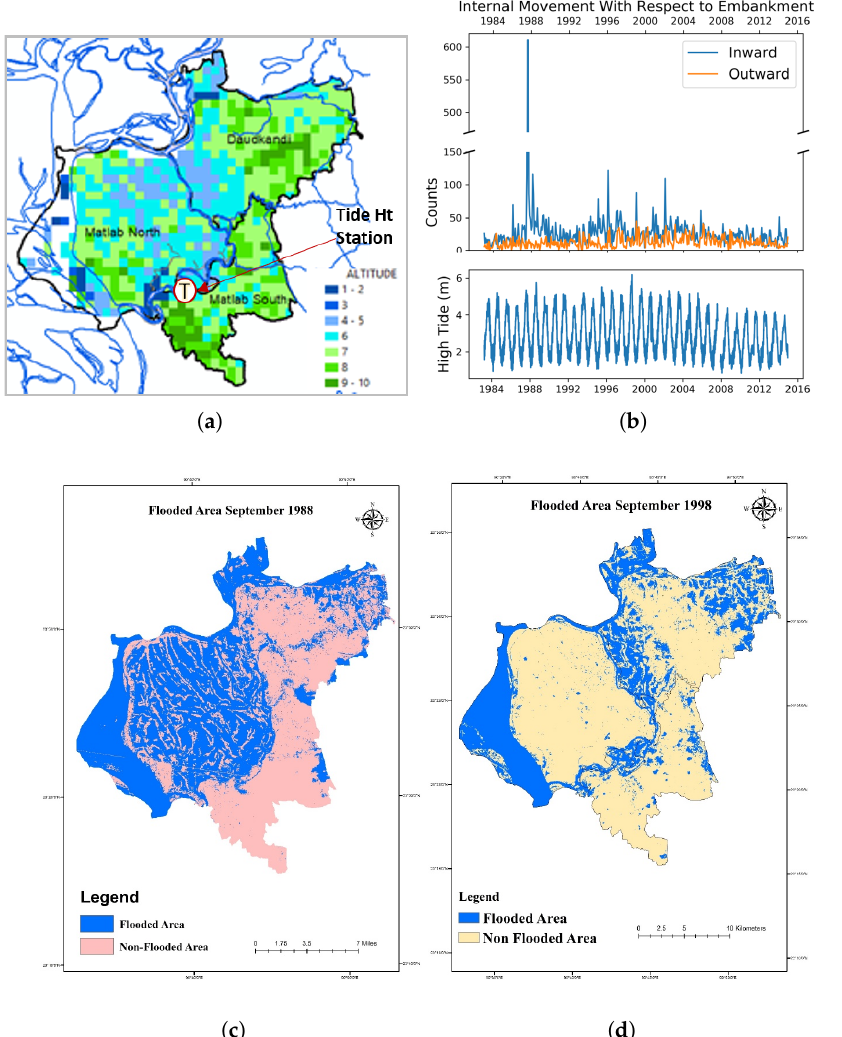
Figure 5. ( a ) Land elevation map of Matlab North, Matlab South and Daudkandi Upazilas based on 20 m × 200 m National DEM data (Source of data: WARPO), ( b,c ) inundated area in Matlab North, Matlab South and Daudkandi Upazilas in two major flood years [delineated from LANDSAT 4-5 TM images using Normalized Difference Water Index (NDWI)], and ( d ) (top) monthly inward/outward movement of households within Matlab, and (bottom) monthly high-tide observed at station located in ( a